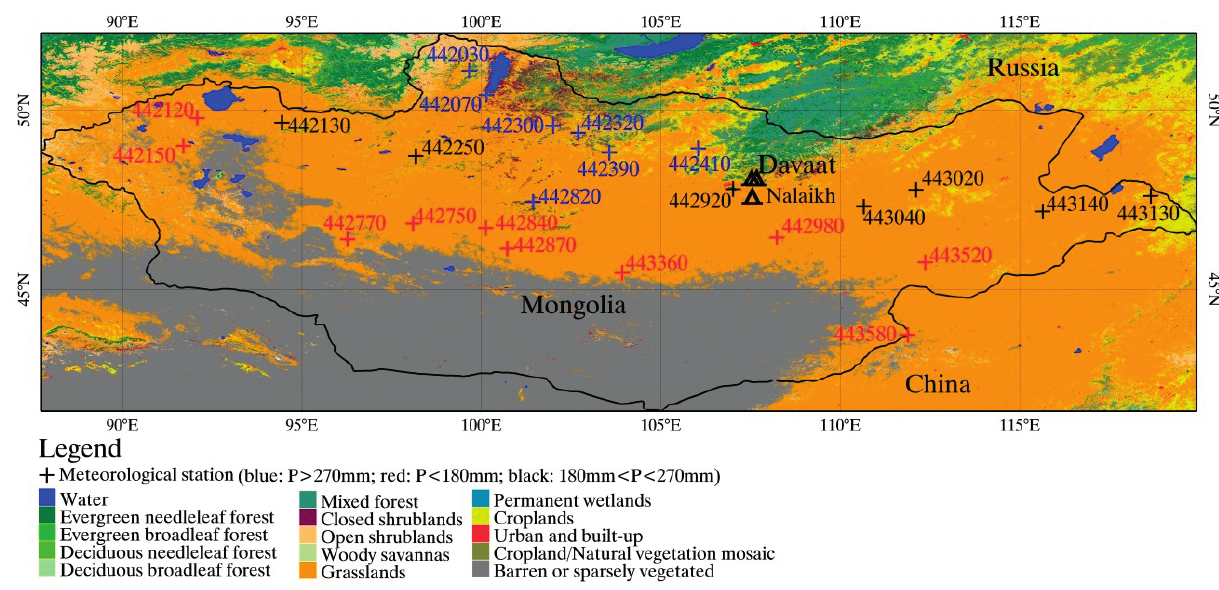
Figure 1. Land covers, meteorological stations, and three experiment sites used in this study. Three automatic weather stations (AWS) are located at Nalaikh and Davaat, near Ulaanbaatar (Figure